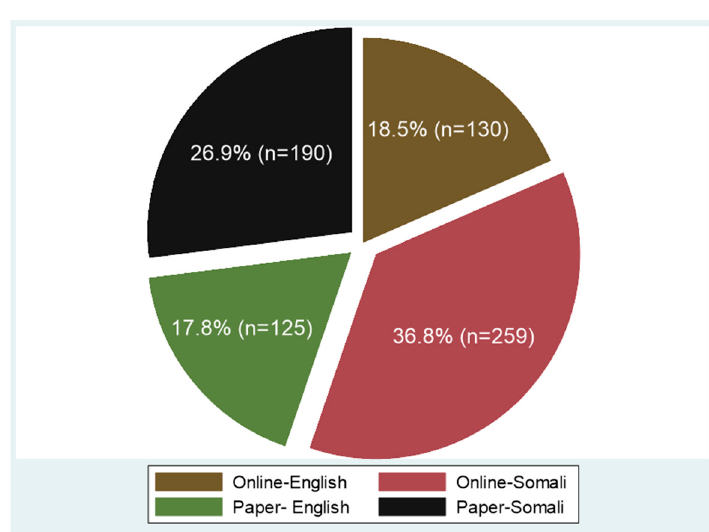
Table A1. Measurement of variables. Figure A1. Data Collection Mode and